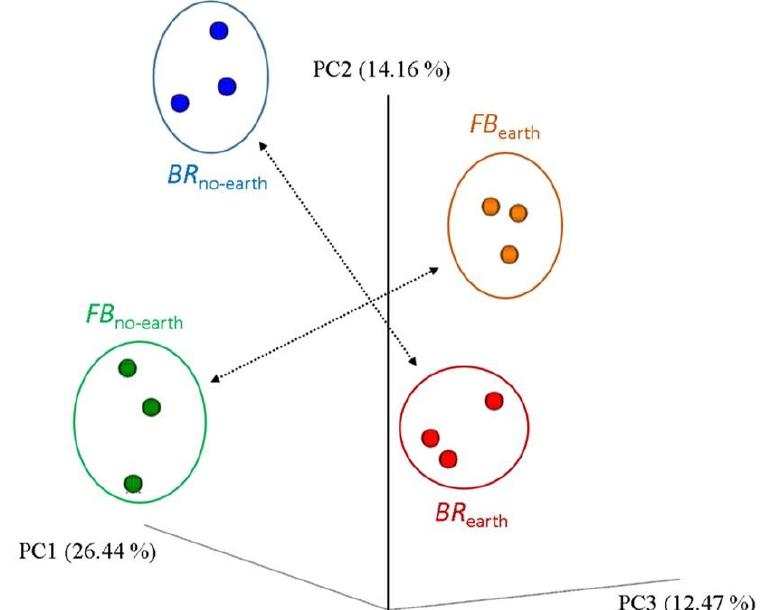
significance was determined using the Kruskal–Wallis test. The measures within each treatment are in triplicate.